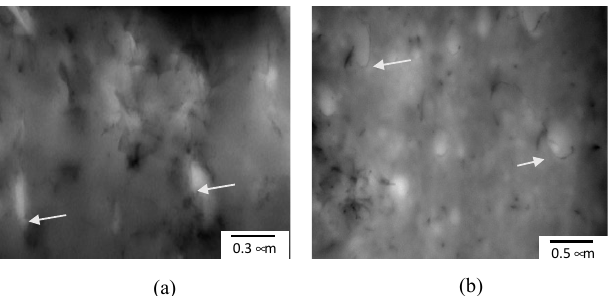
Figure 3. TEM of the PS/aPA (25:75) system, with 1.5 vol% CNT and 3 vol% PSMA (MO II) at different magnifications: ( a ) higher magnification, ( b ) lower magnification. It can be seen with PSMA addition, that the CNT selectively localize at the interface between PS and aPA. White arrows show CNT at the interface between PS drops and aPA matrix.